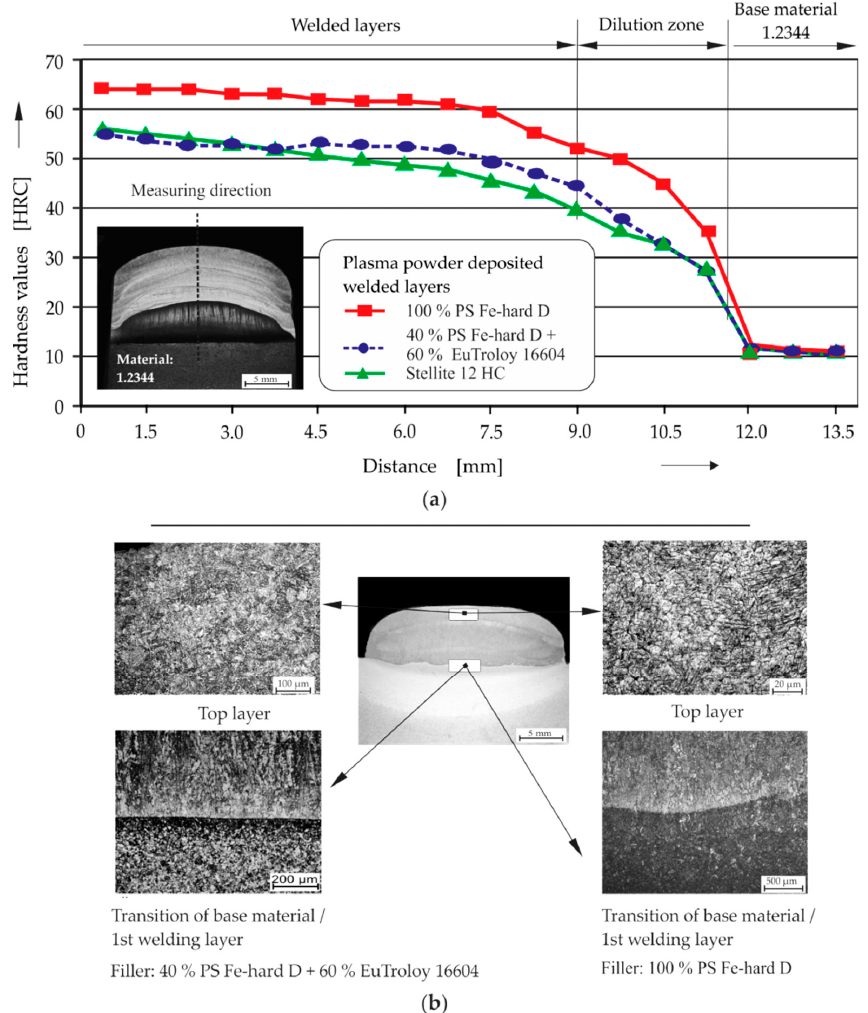
Figure 4. Weld metal structure and hardness curve of the plasma deposition-welded iron-base alloy: ( a ) measured hardness profiles over the welded layers depth and ( b ) microstructure after PMD in different areas.